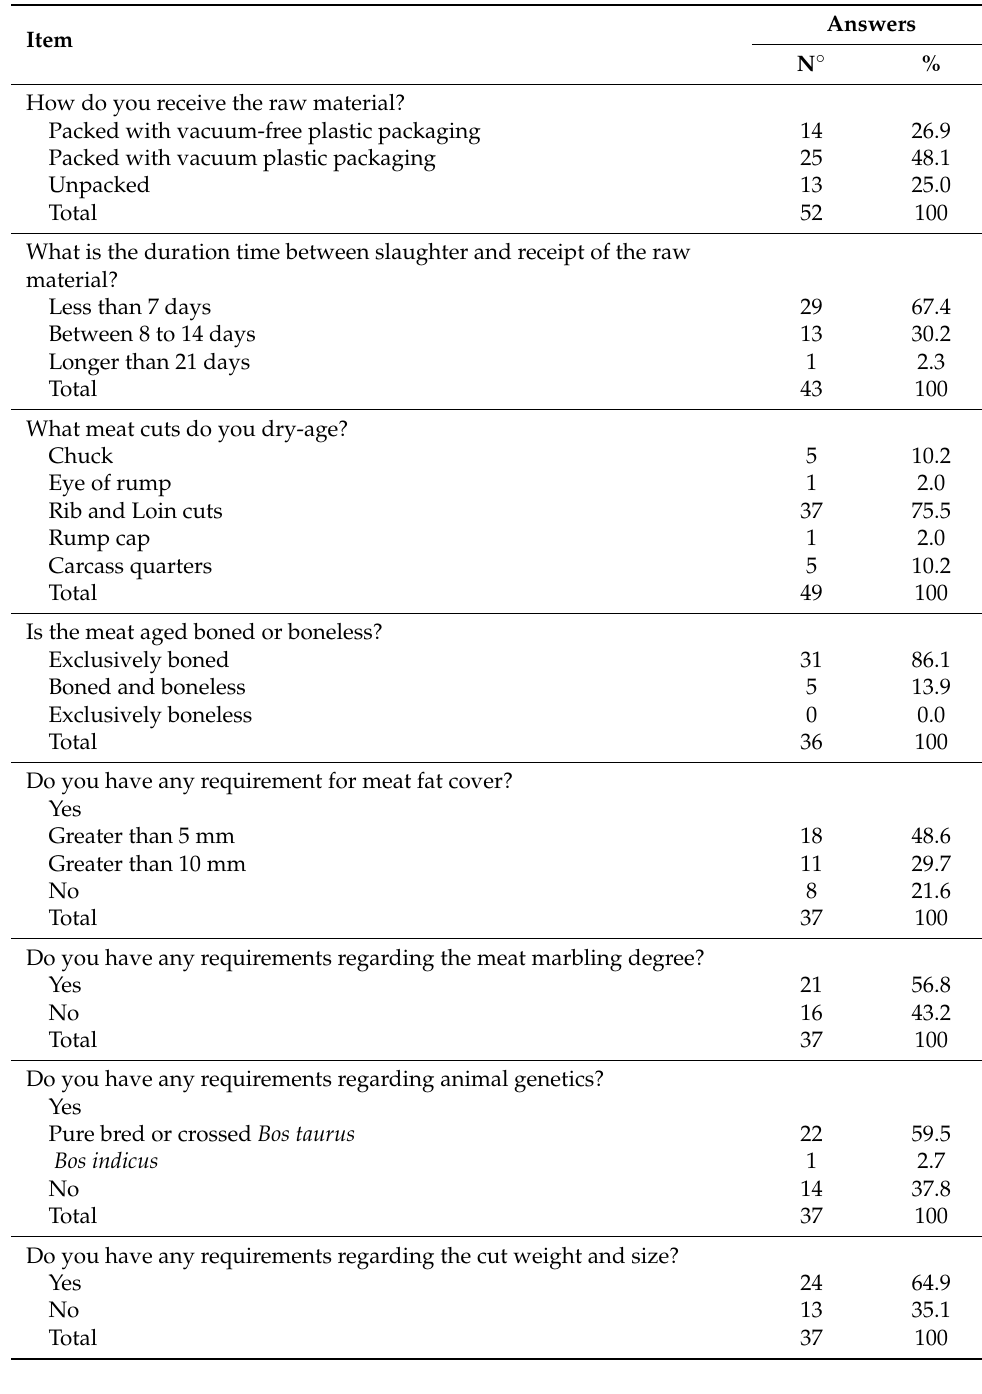
Table 4. Information on raw materials used for dry-aged meat in